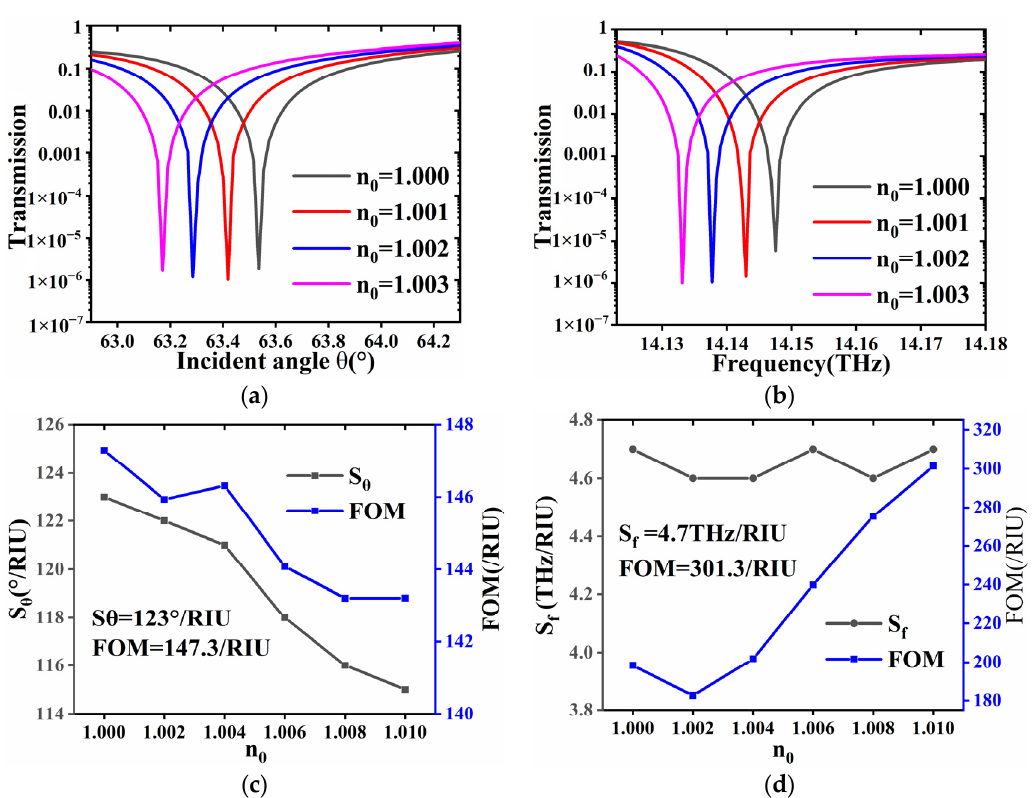
Figure 4. Performance of sensing e ff ect in frequency and angle. ( a , b ) show the variation of transmittance in angular and frequency spectrum under di ff erent n 0 . ( c , d ) extract the sensitivity and FOM of the Transmission spectrum corresponding to di ff erent refractive index gases from 1.00 to 1.01.